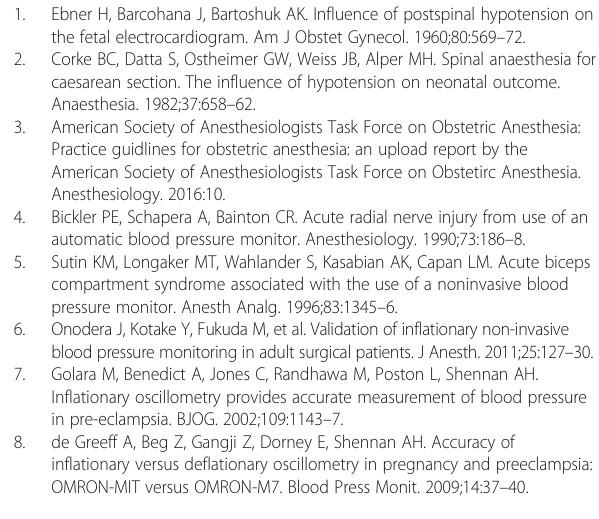
Table 2 Comparison of the speeds of detection of hypotension by different devices No hypotension iNIBP dNIBP p value The number of cases in 24 which hypotension was detected faster ( n (%))